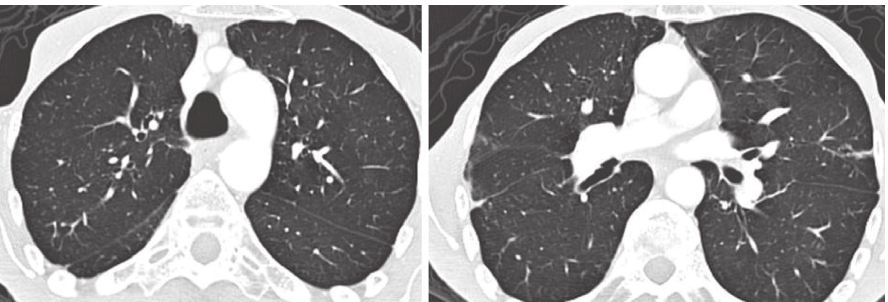
Figure 3: Thorax CTperformed in 2016. There is no apical fibrotic changes and traction bronchiectasis in the upper zone of the right lung.